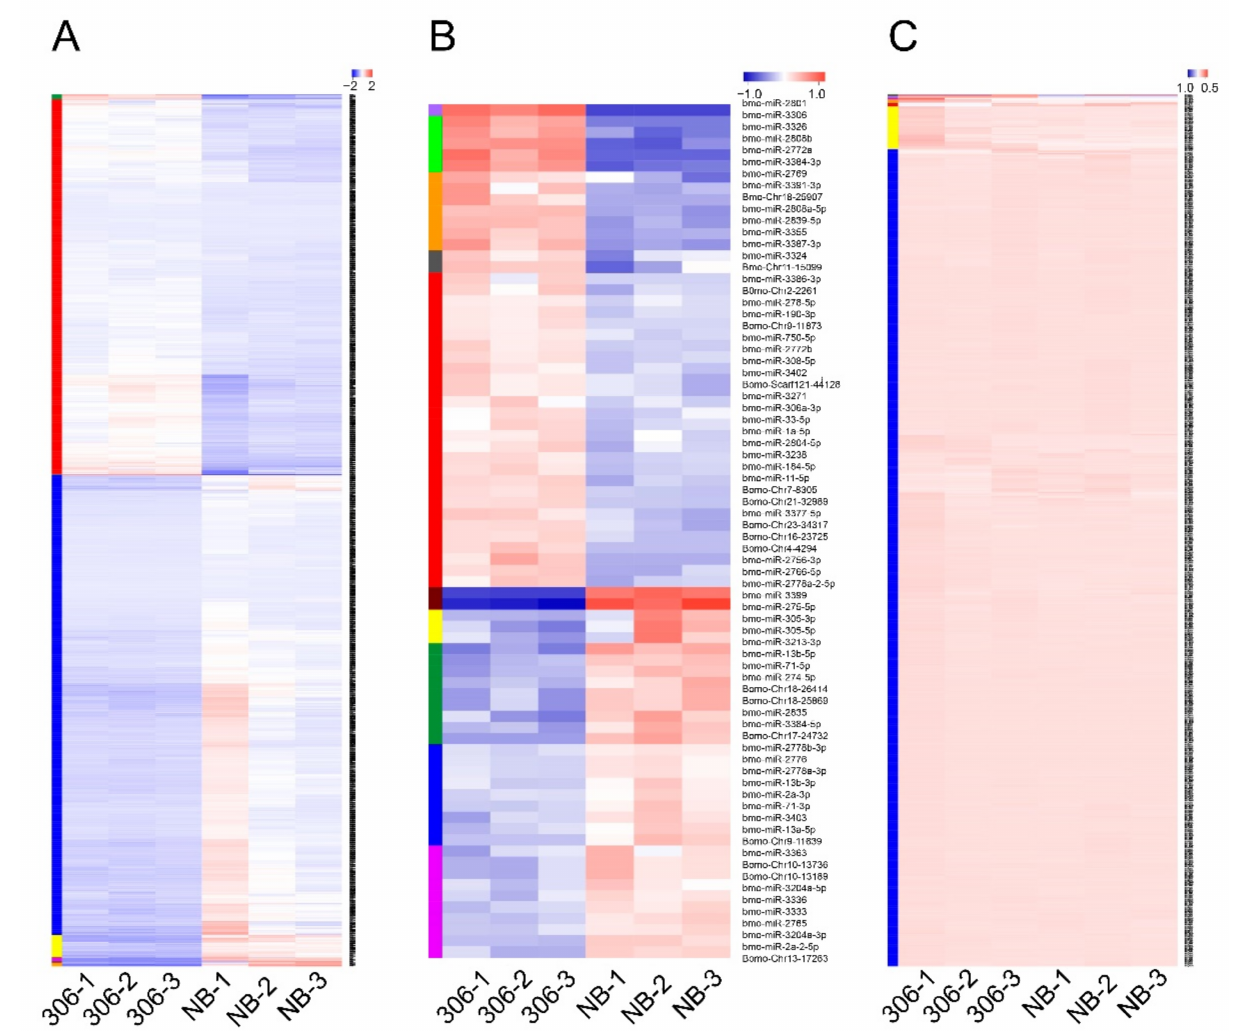
Figure 1. Hierarchical cluster analysis of whole transcriptome sequencing mRNA, miRNA, and circRNA in the yellow cocoon strain silkworm (NB) and the white cocoon strain silkworm (306). ( A ) DE-mRNA hierarchical cluster analysis, in which the relative expression level of mRNAs was expressed as a color range from a low level ( − 2, blue) to a high level (2, red); ( B ) DE-miRNA hierarchical cluster analysis, in which the relative expression level of miRNAs was expressed as a color range from a low level ( − 1, blue) to a high level (1, red); ( C ) DE-circRNA hierarchical cluster analysis, in which the relative expression level of circRNAs was expressed as a color range from a low level ( − 1, blue) to a high level (0.5,